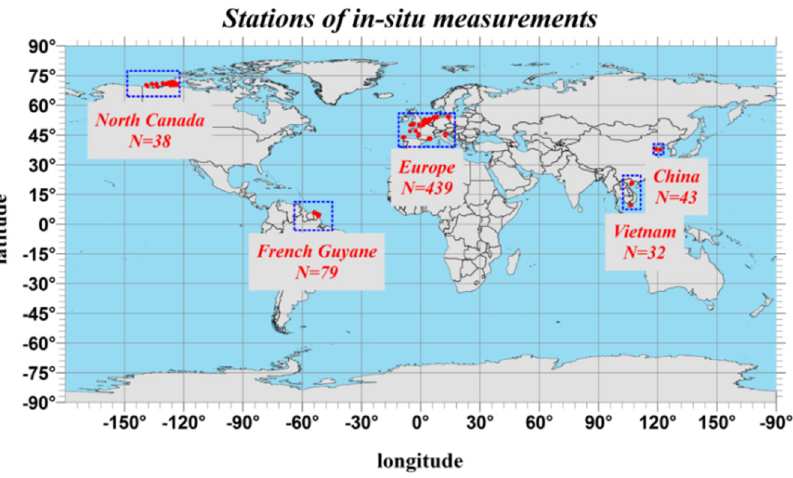
Figure 2. Location of the in situ data points used for the development and validation of the different SPM algorithms. N represents the number of in situ ( R rs ( λ ), SPM ) data points for each sampled region.